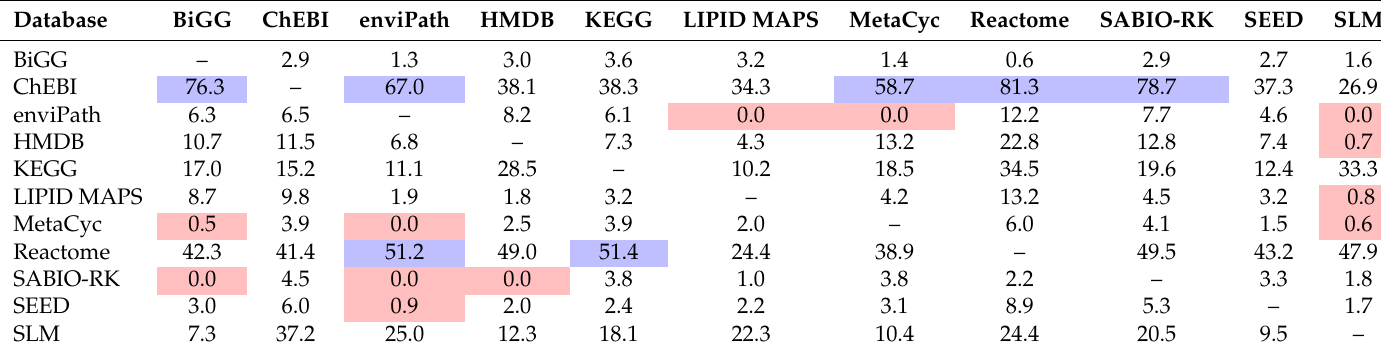
Table 6. Percentage of IDs in the database (column) that gets mapped to more than one ID in the database in the corresponding row using database names as a bridge. Blue boxes are used to highlight highest numbers. While red boxes indicate lowest